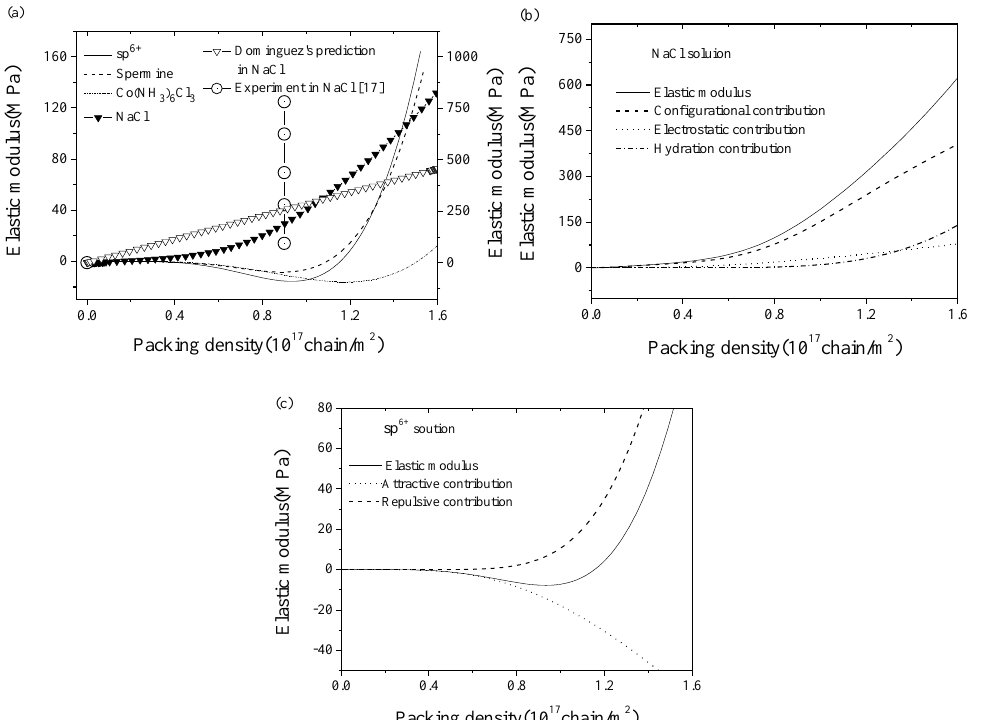
Figure 3. ( a ) Theoretical elastic modulus variation (lines) of dsDNA films with packing density in sp 6+ , spermine, Co(NH 3 ) 6 Cl 3 , NaCl solutions, and Dom í nguez’s AFM experiment results [17] (circles) in NaCl solution. The left longitudinal axis is related to DNA in multivalent solutions and the right one is related to DNA in NaCl solution. ( b ) Contributions of electrostatic energy, hydration energy, and configurational entropy to the elastic modulus in NaCl solution. ( c ) Contributions of the repulsive and attractive part of free energy to the elastic modulus in sp 6+